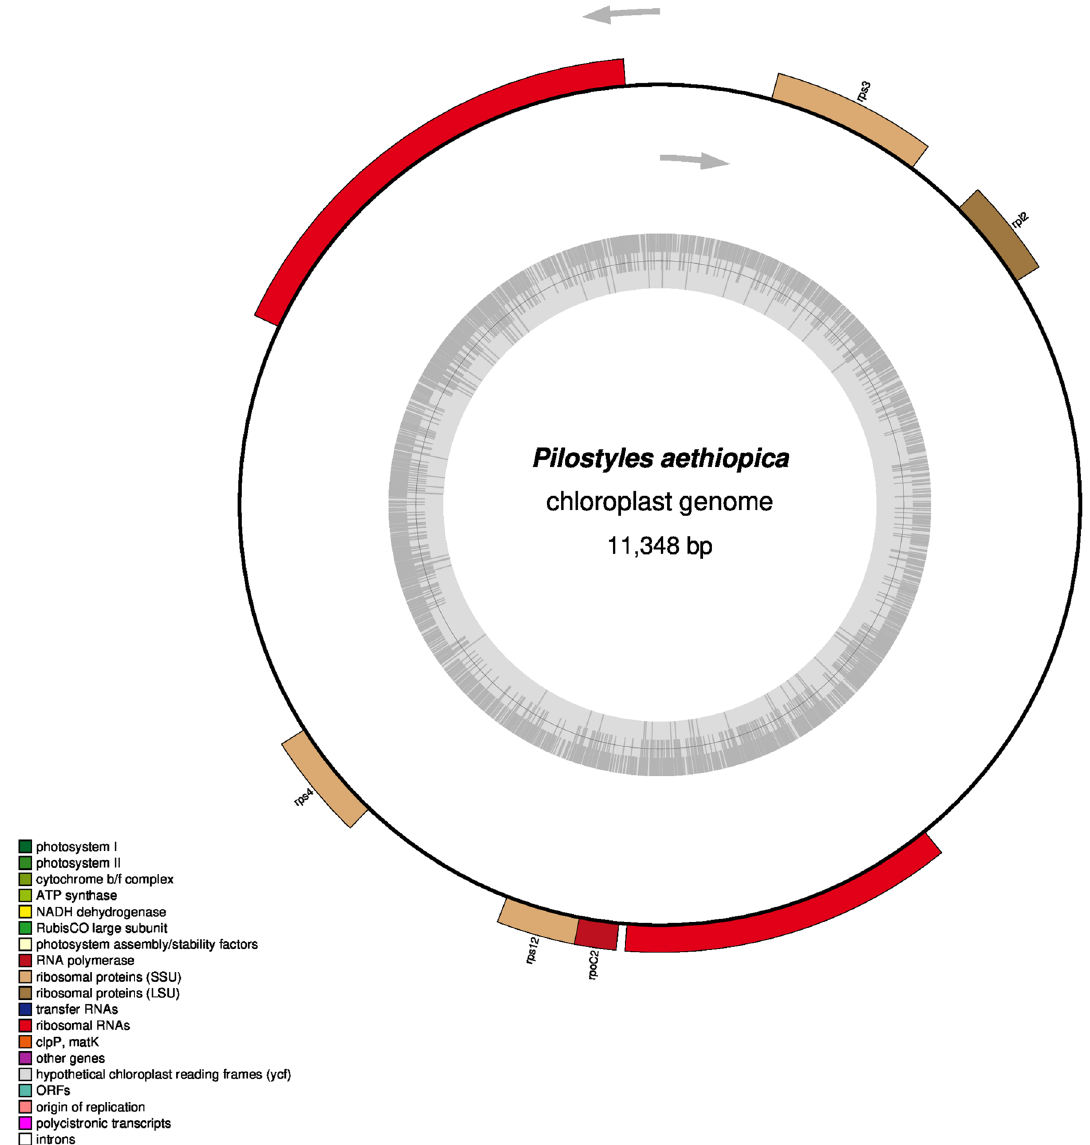
Figure 1. OGDRAW map of Pilostyles aethiopica (NC_029235.1) chloroplast genome. The map shows the loss of tRNA genes and inverted